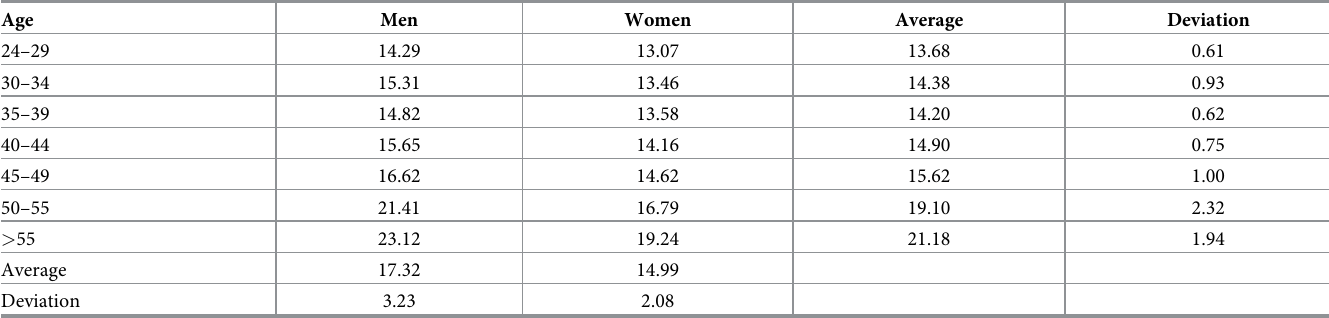
Table 9. Age of the author, and impact on